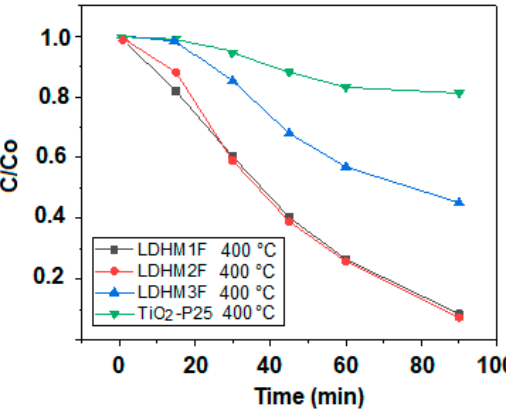
Figure 9. Relative photodegradation rate of 80 ppm of 2,4,6-trichlorophenol.